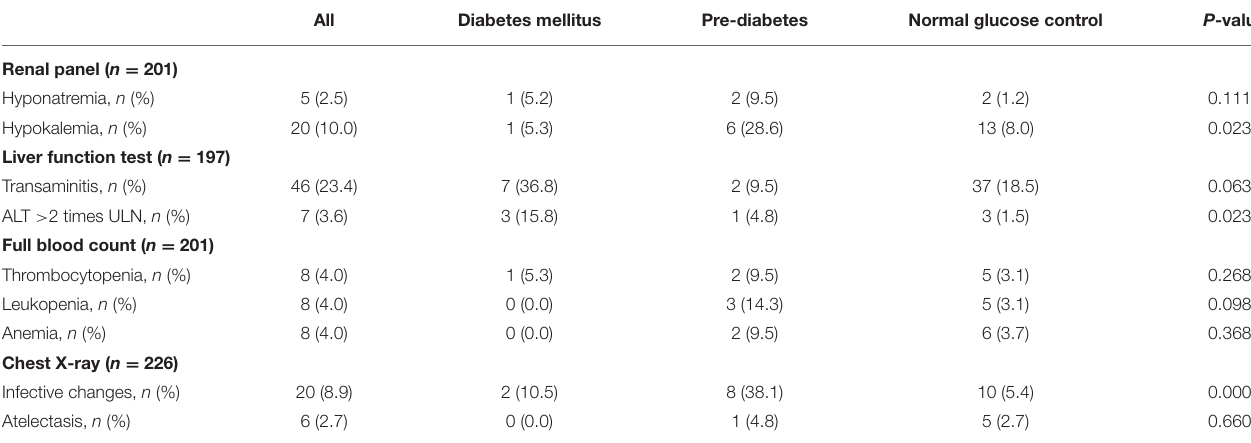
TABLE 4 | Incidence of laboratory and radiographical abnormalities stratified by diagnosis of diabetes mellitus and pre-diabetes. All Diabetes mellitus